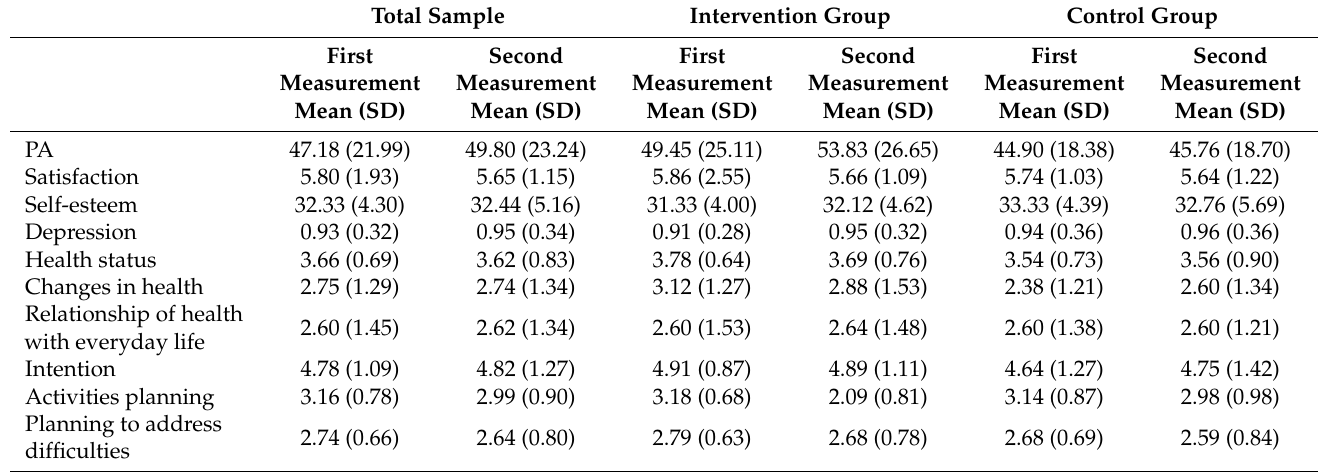
Table 4. Mean and standard deviation of the studied variables in the total sample and in the two